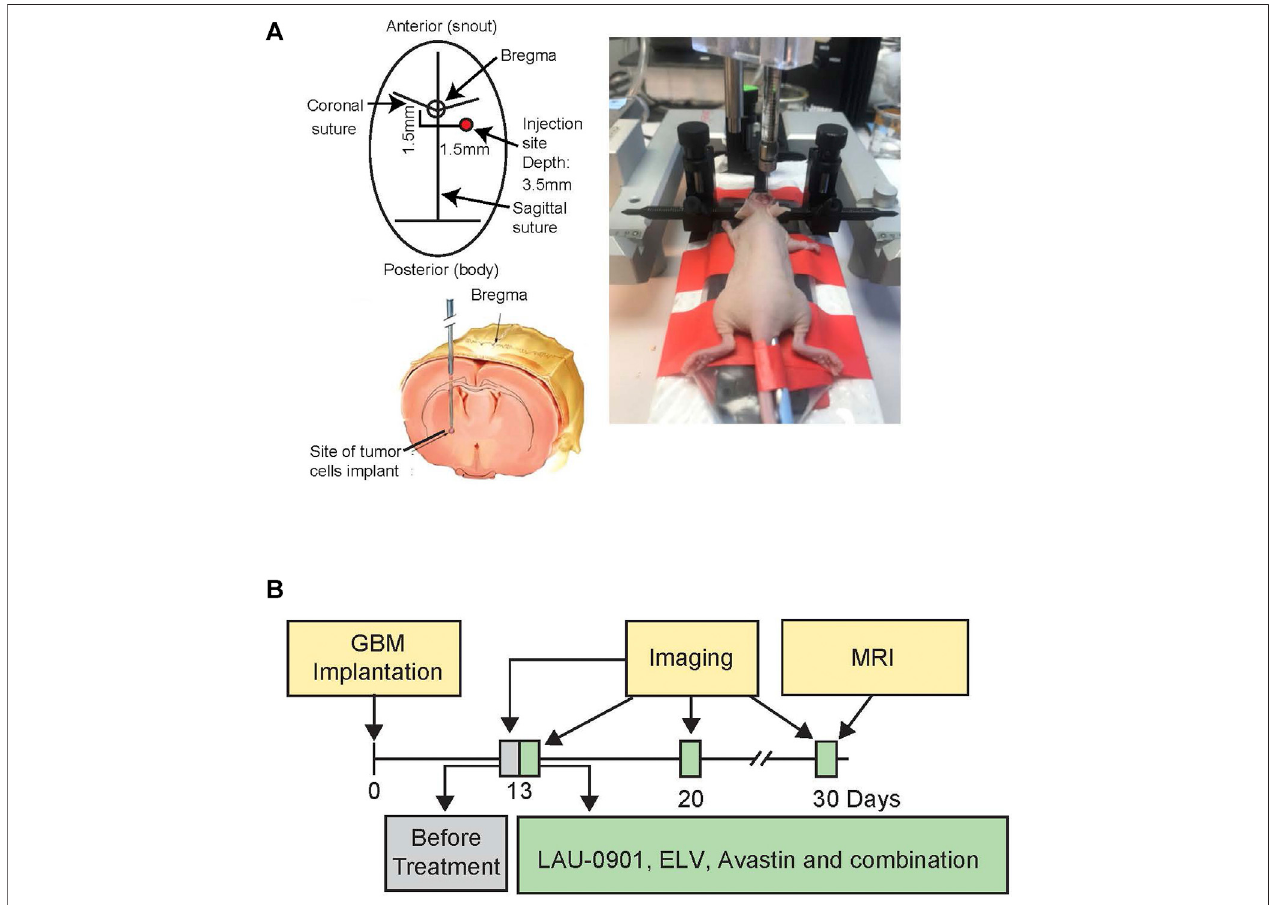
FIGURE 3 | (A) Experimental design, showing bregma level and site of tumor cell implantation in anesthetized athymic nude female mice, secured in a stereotactic head frame. (B) Timeline showing GBM implantation, imaging, and treatments. Mice underwent stereotactic implantation ofthe luciferase-modi fi ed U87MG cells on day 0 and were monitored during a 30-day survival period. Treatment was started on day 13 post-implantation. In vivo bioluminescent imaging was performed on days 13, 20, and 30 post-implantation. On day 30, mice were sacri fi ced, and ex vivo MRI was conducted on perfused